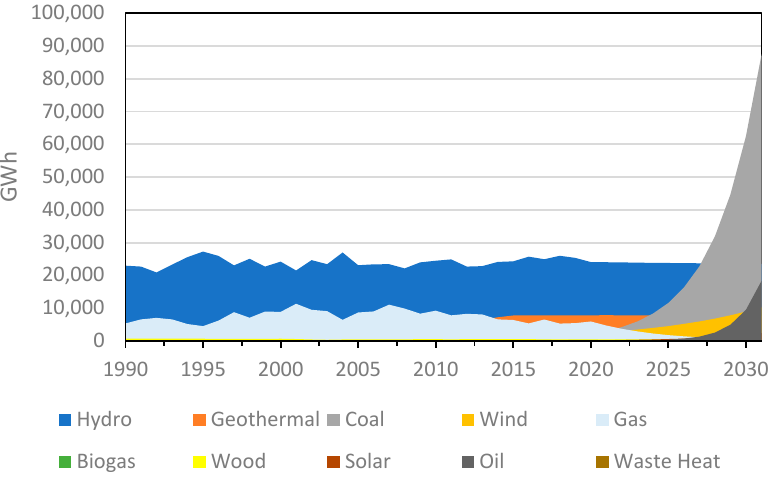
Figure 1. Forecast of electricity generation by fuel in New Zealand.